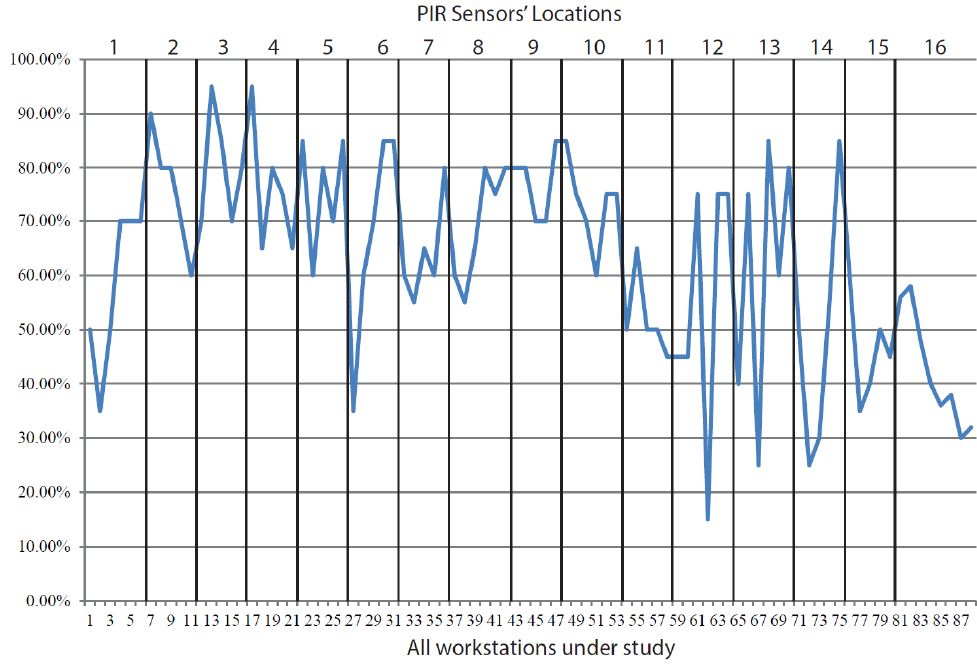
Figure 3. Occupancy rate at each workstation by head counting. Figure 13. Occupancy rate at each workstation by head counting.